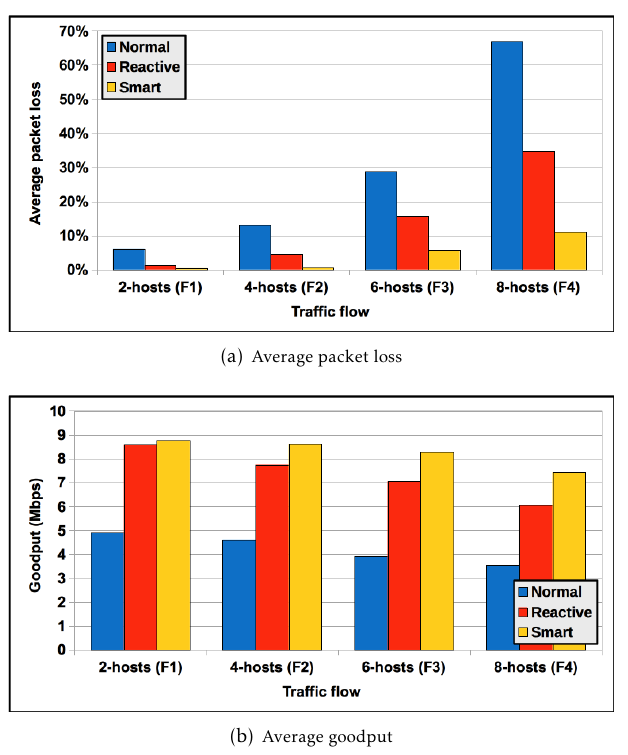
Figure 6. Network